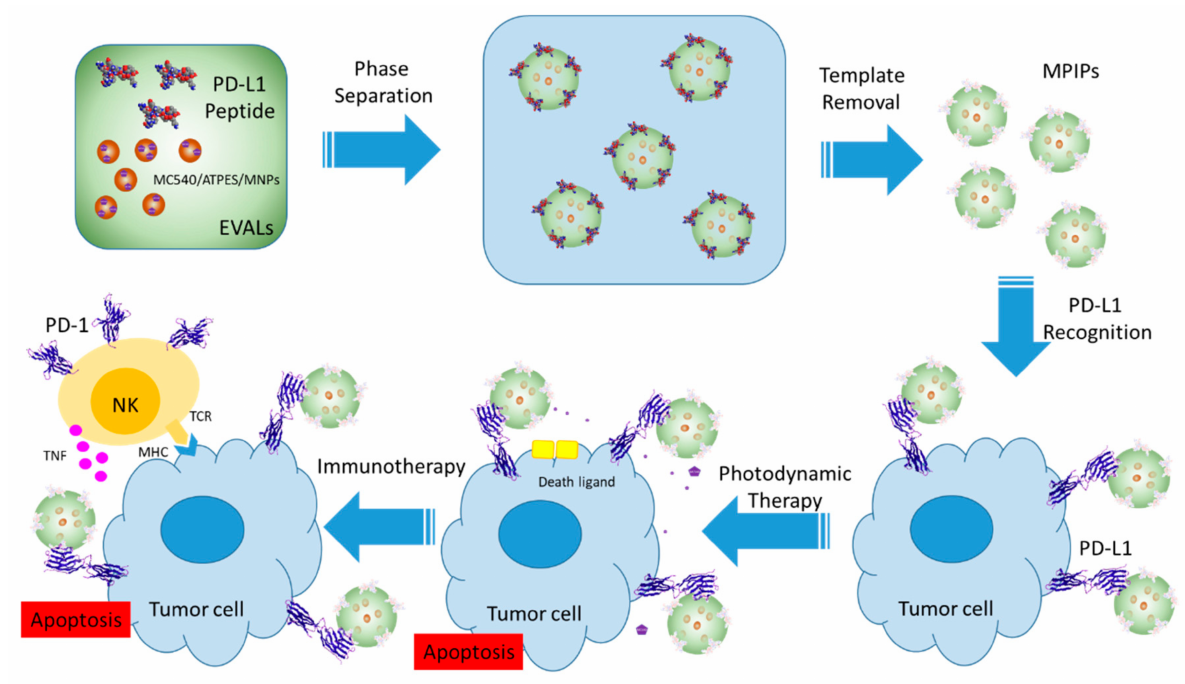
Figure 1. Preparation and administration of multifunctional magnetic PD-L1 peptide-imprinted composite